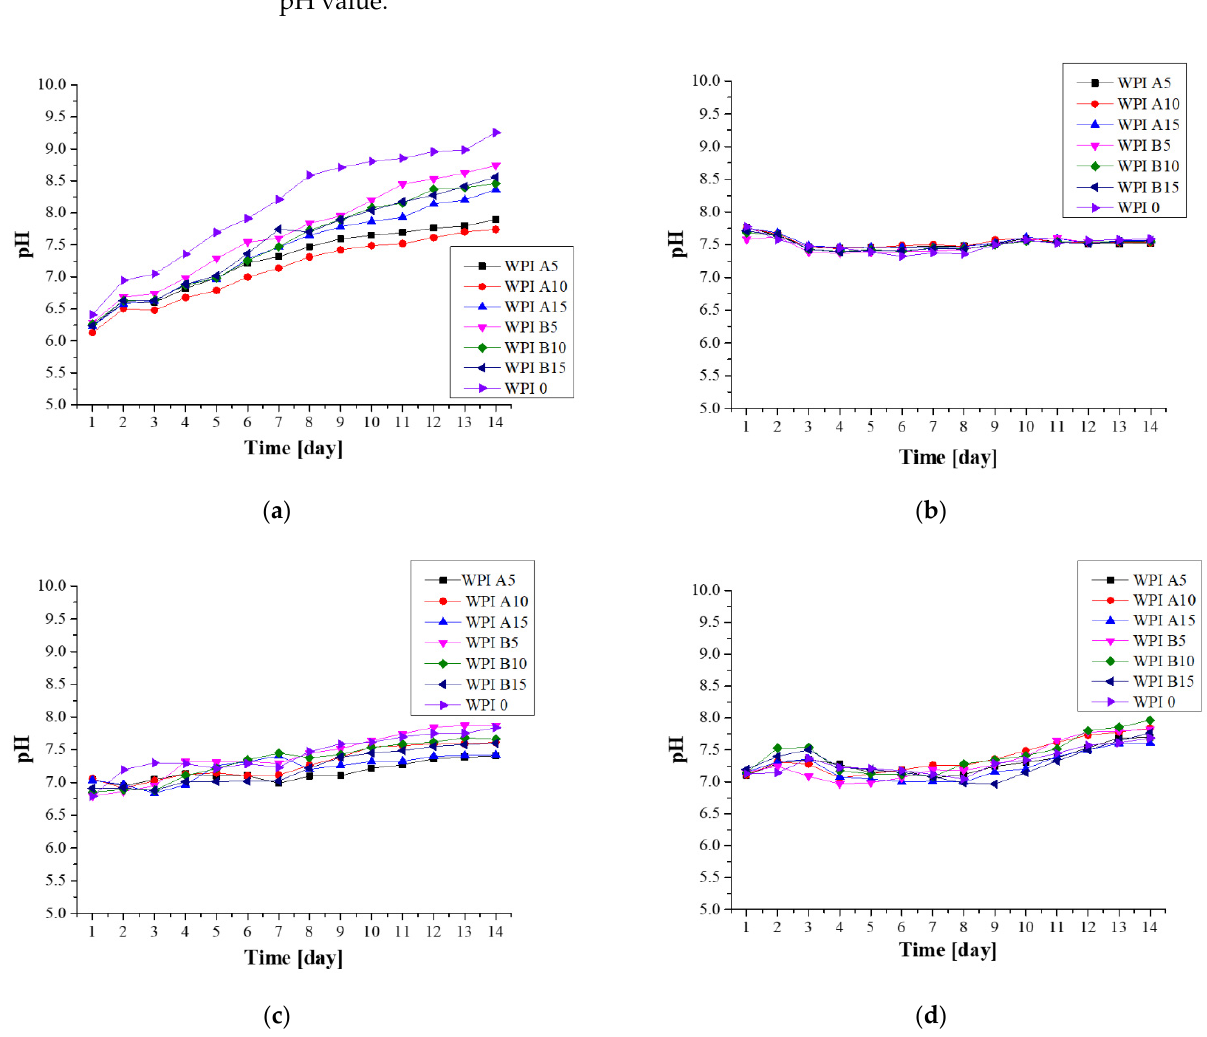
Figure 4. Potentiometry analysis of the hydrogels during a 14-day incubation in fluids simulating the biological environment: ( a ) incubation in artificial saliva; ( b ) incubation in SBF; ( c ) incubation in Ringer’s fluid; ( d ) incubation in distilled water.